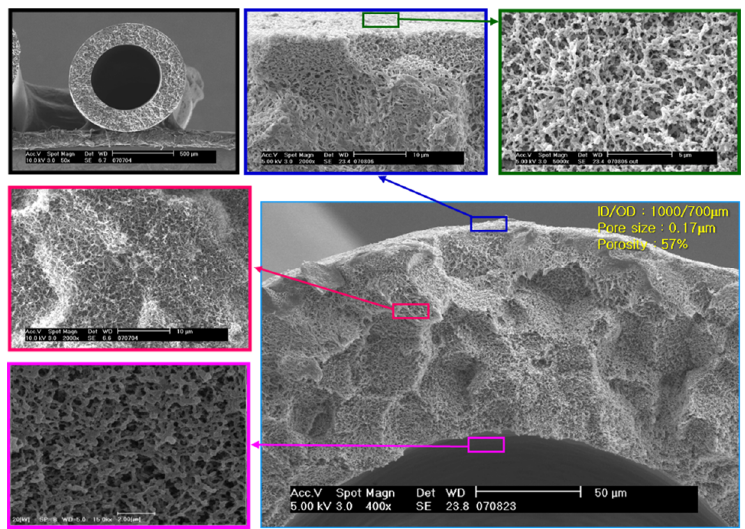
Figure 4. SepraTek’s porous polypropylene hollow fiber membrane fabricated by thermally induced phase separation (TIPS)